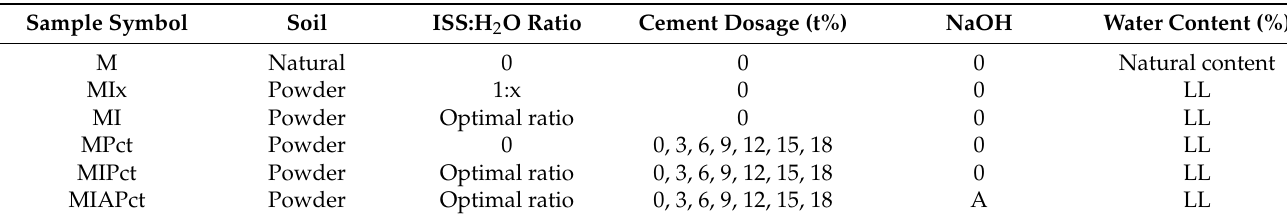
Table 3. Symbols and compositions of different types of samples (ISS:H 2 O ratio = 1:x, where x = 25, 50, 75, 100, 125, 150, 175, 200; Cement dosage (t%): the ratio of dry weight of Portland cement to dried soil powders; LL: liquid limit; A: the amount of NaOH added until pH-value of the sample reached neutral before adding